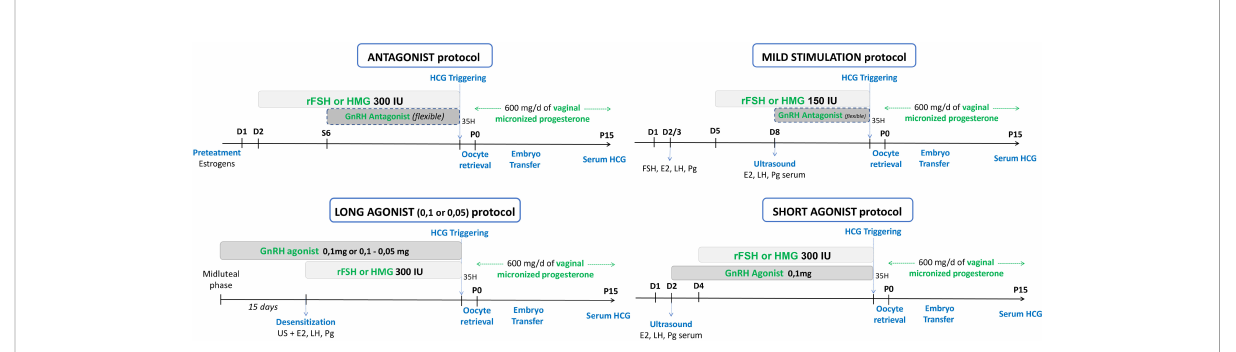
FIGURE 2 Previous standard protocol for POR: antagonist protocol, long and short agonist protocol, mild